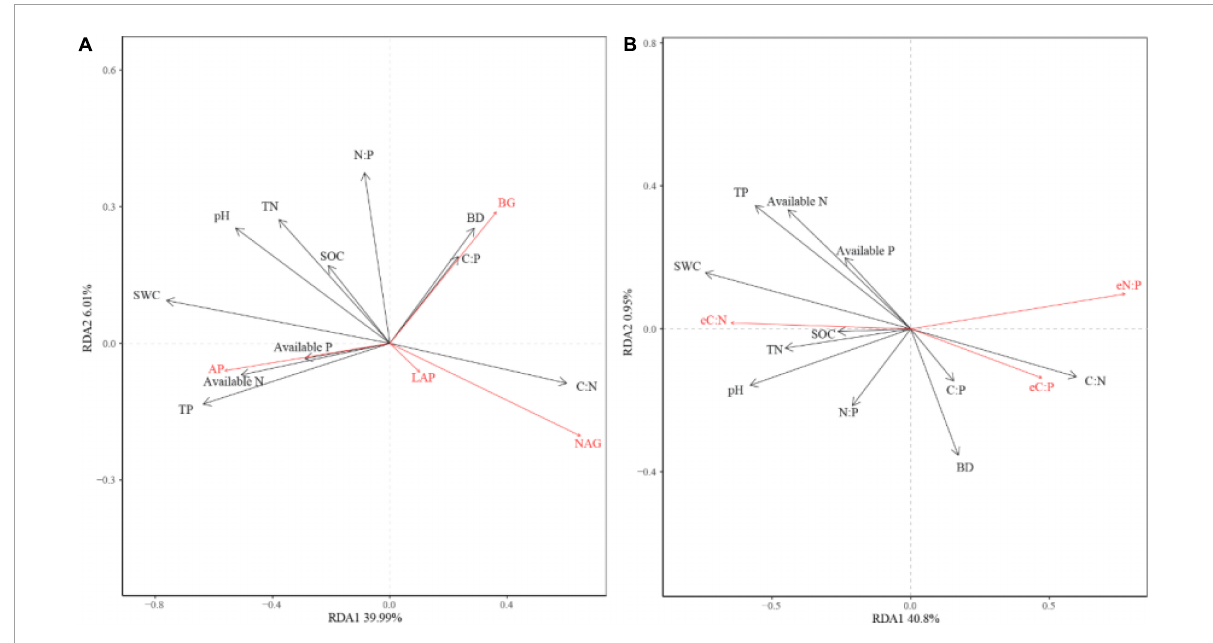
FIGURE4 Redundancy analysis of the soil enzyme activities (A) and soil enzyme stoichiometry (B) . NDT, non-degraded tiankeng; MDT, moderately degraded tiankeng; HDT, heavily degraded tiankeng; OT, outside tiankeng; BG, β -1,4-glucosidase (nmol g − 1 SOC h − 1 ); NAG, β -1,4-Nacetylglucosaminidase (nmol g − 1 SOC h − 1 ); LAP, L -leucine aminopeptidase (nmol g − 1 SOC h − 1 ); AP, acid phosphatase (nmol g − 1 SOC h − 1 ); eC:N, eC:P, and eN:P represent BG:(NAG + LAP), BG:AP, and (NAG + LAP):AP, respectively; BD, soil bulk density; SWC, soil water content; SOC, soil organic carbon; TN, total nitrogen; TP, total phosphorus; Available N, available nitrogen; Available P, available